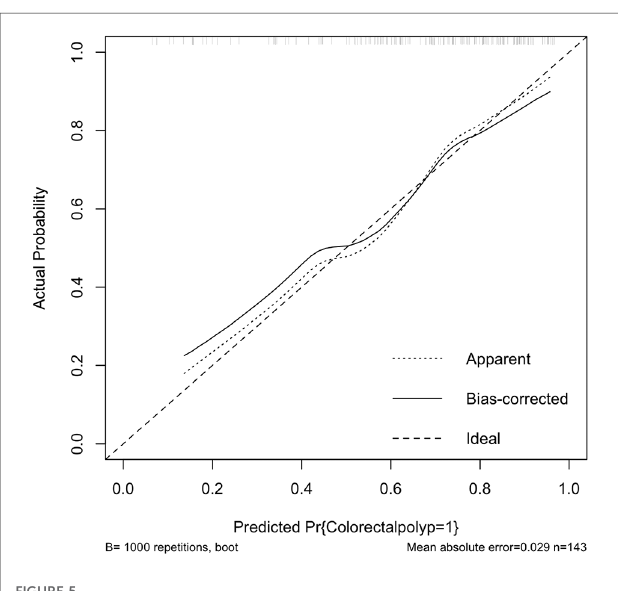
FIGURE 5 External validation of the column diagram: calibration curve. Of note: C index: